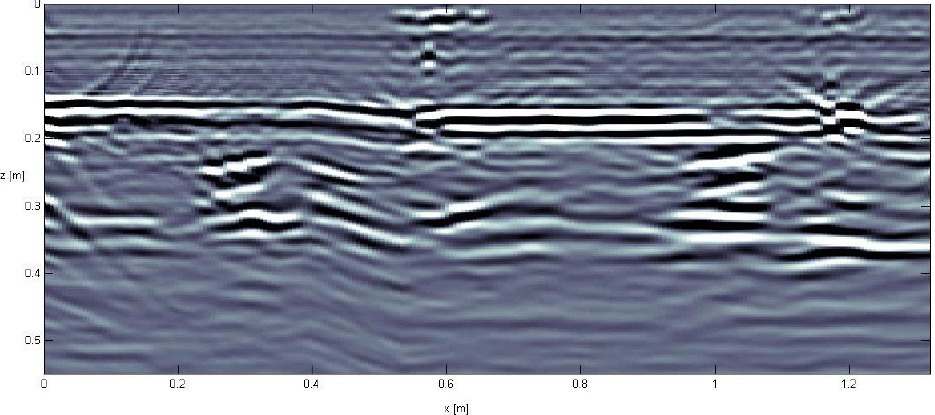
Figure 7. Joined time-depth conversion with horizontal variation of the propagation velocity, related to the result of Figure 6.